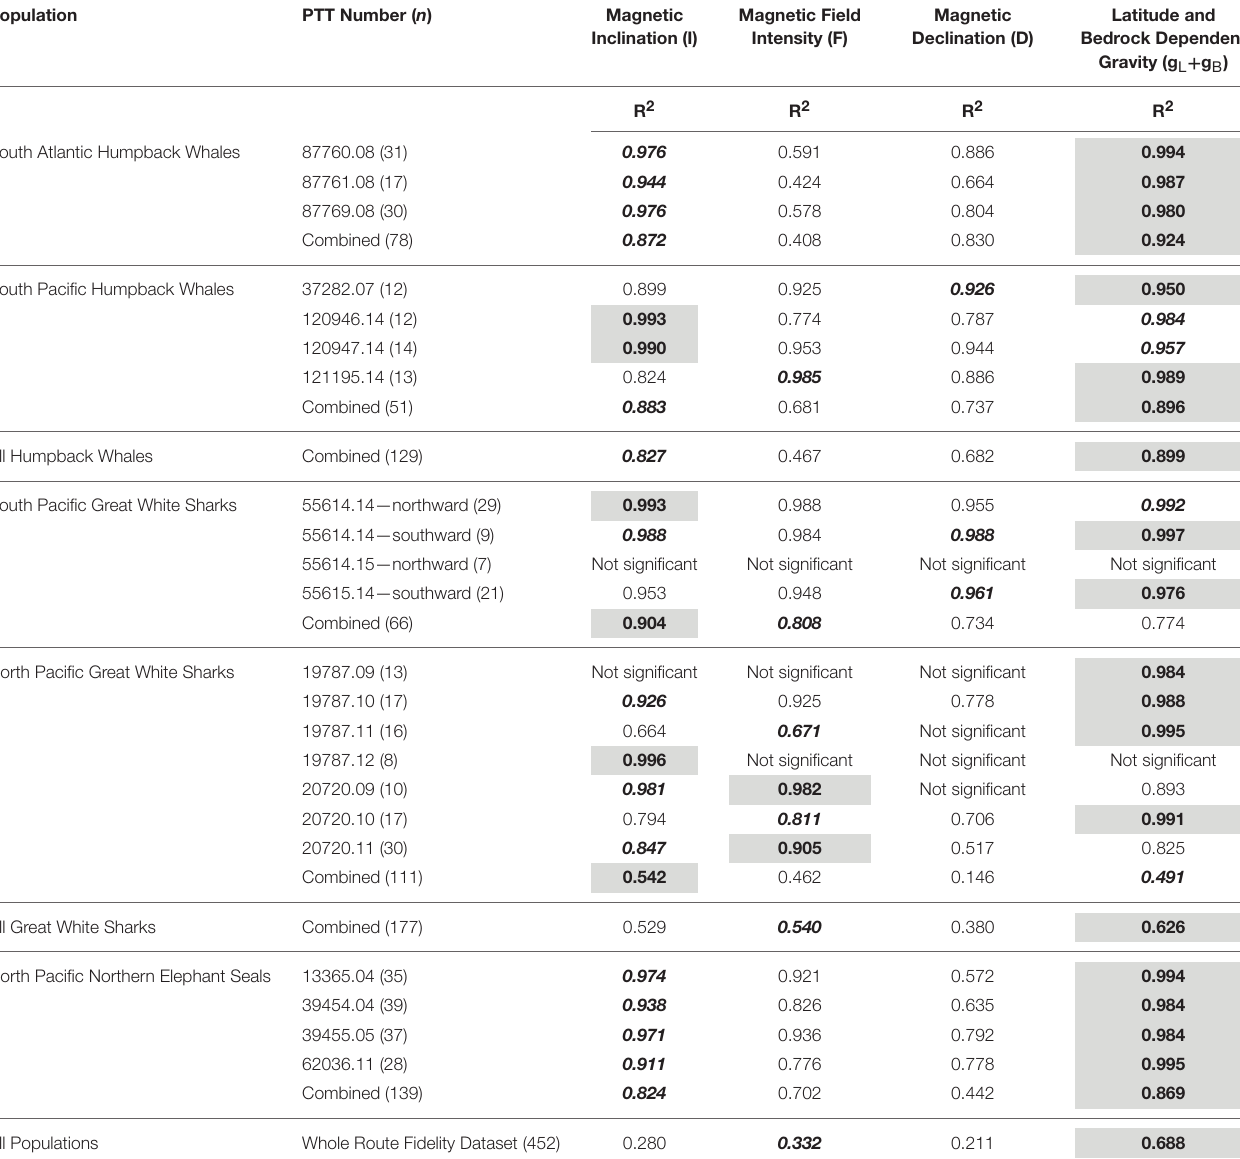
TABLE 2 | Significant ( p < 0.05) sinusoidal regression correlation coefficients for route fidelity movements in geophysical coordinates relative to moon illumination.